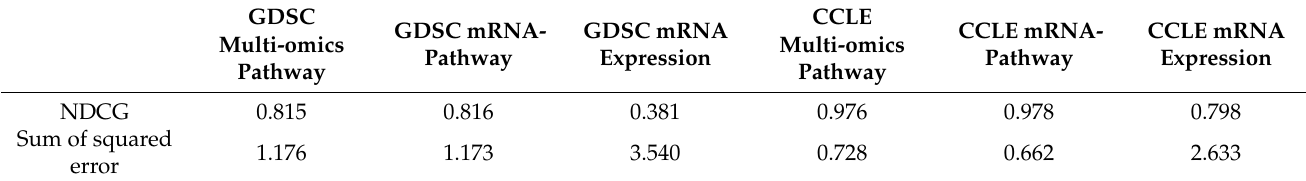
Table 1. Performance and robustness comparison on drug